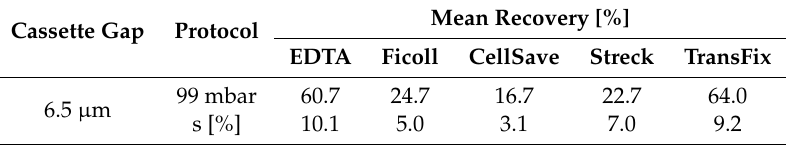
Table 2. Mean tumor cell recovery rates determined from spike experiments (using MDA-MB-468 tumor cell line cells) for 6.5 µ m cassette gap and various additional blood sample fixatives. Recovery percentages and standard deviation (s) for each blood processing type and tube are